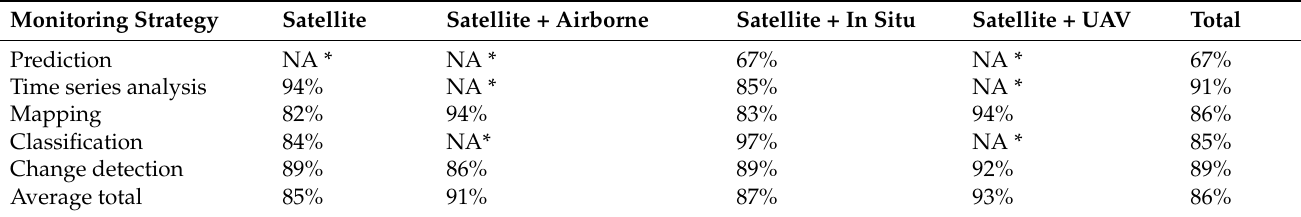
Table 3. Average accuracy per monitoring strategy for each type of remote sensing data. Note: air- borne data were excluded, as only one article used this data type, and the accuracy was not